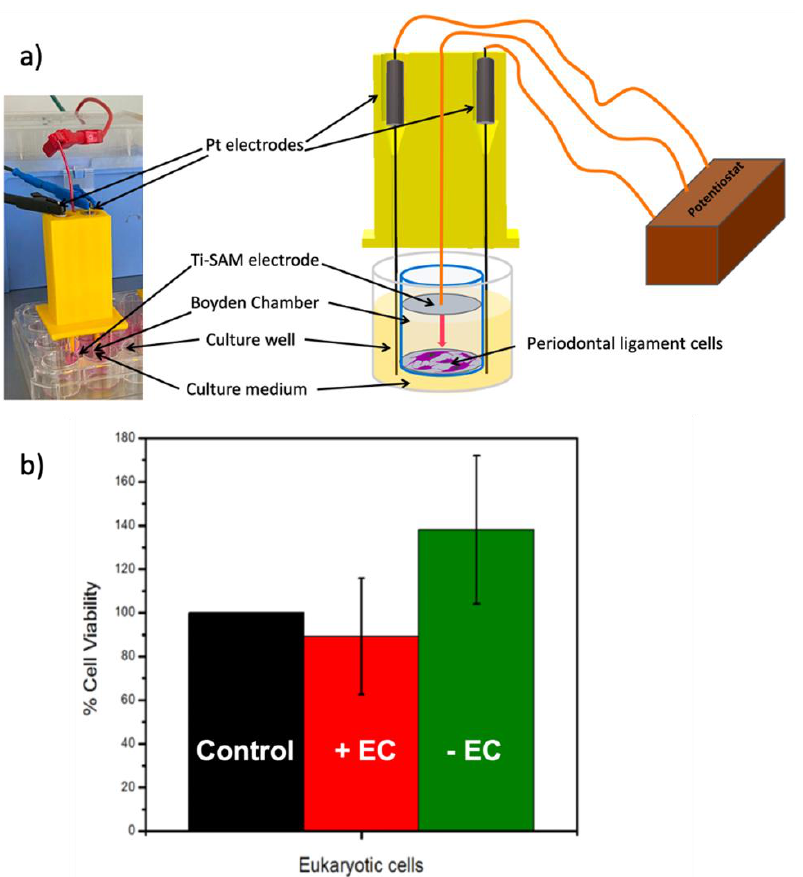
Figure 5. ( a ) Three-dimensional-imprinted device for the realization of the tests on eukaryotic cells. The Ti-SAM electrode is in contact with cells in the Boyden chamber, while the two Pt electrodes pass through the holes in the culture well. ( b ) % Cell viability of eukaryotic cells with and without electrochemical activation of 3-modified titanium surfaces.